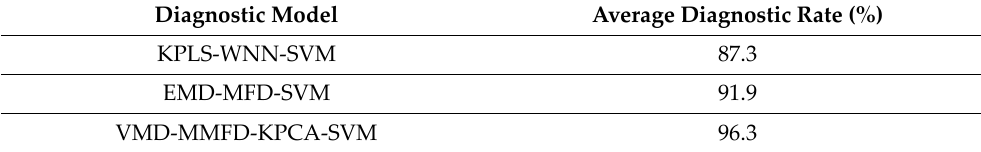
Table 7. Fault Diagnosis